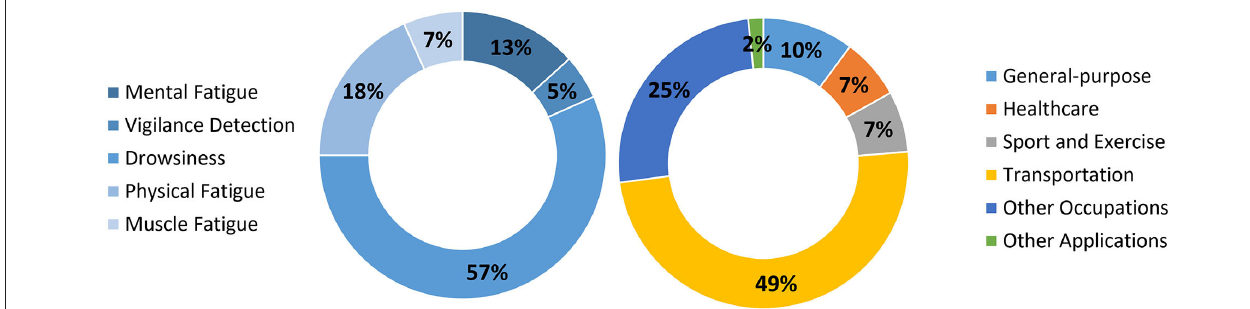
FIGURE 2 | Type of fatigue and technology application